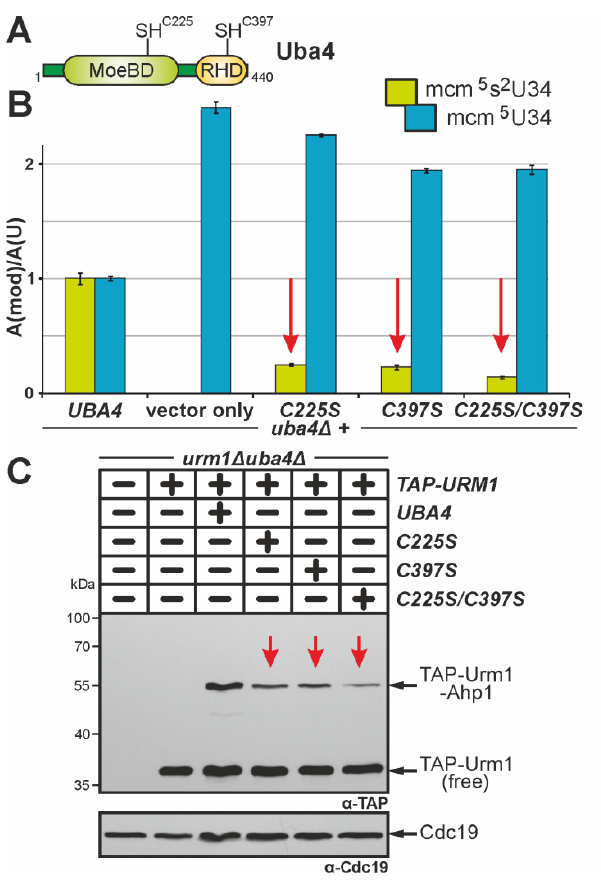
FIGURE 4: Cys225 and Cys397 are critical but not essential for Uba4 to activate Urm1 functions in tRNA thiolation and urmyla- tion. (A) Uba4 scheme depicting MoeBD and RHD regions and the positions of Cys225 and Cys397. (B) tRNA (thio)modification anal- ysis via LC-MS/MS (see Fig. 3) reveals Cys225 and/or Cys397 sub- stitution mutants significantly interfere (red arrows) with for- mation of the mcm 5 s 2 U34 modification. (C) Ahp1 urmylation is strongly (red arrows) affected by the C225S, C397S and C225S/C397S mutants. Urmylation assays (see Fig. 2) involved anti-TAP-based EMSA to detect non-conjugated (free) TAP-Urm1 and TAP-Urm1•Ahp1 conjugates. Protein loading was controlled with anti-Cdc19